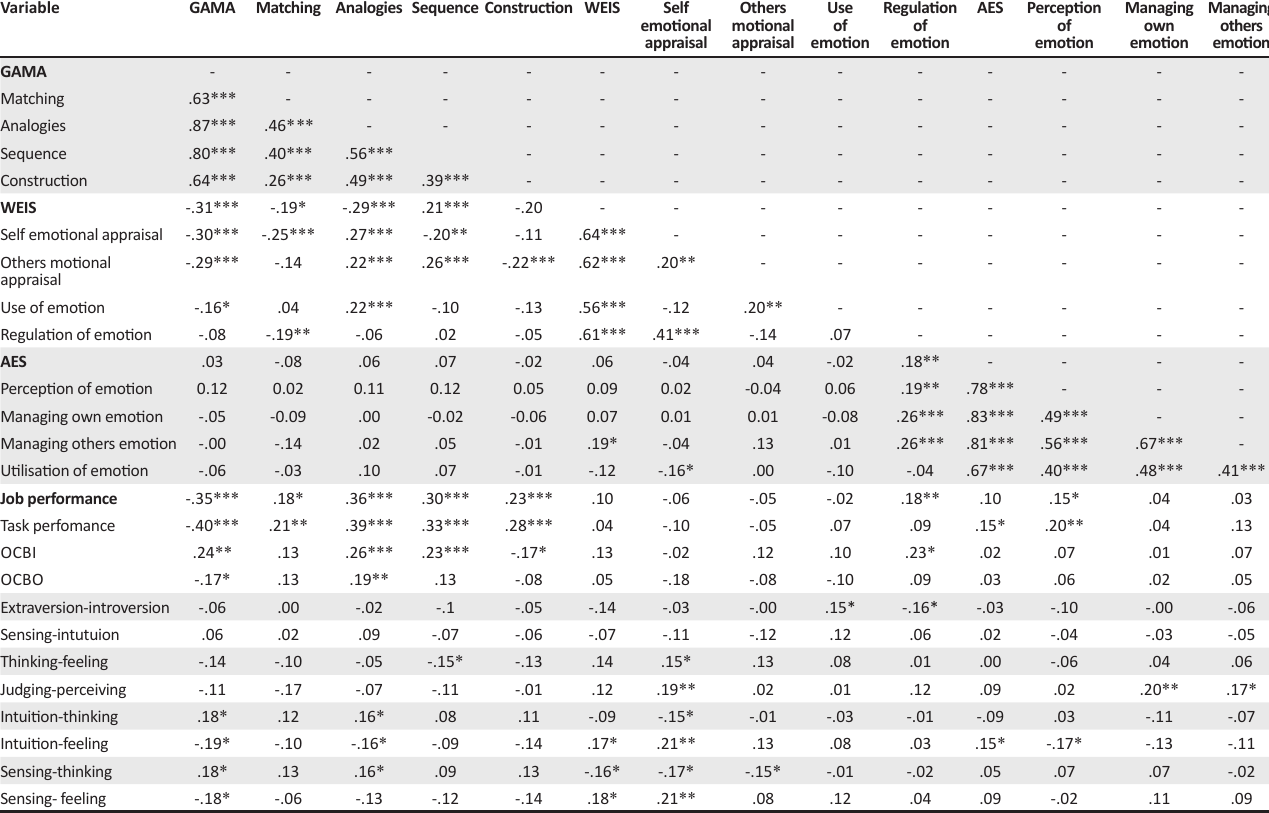
TABLE 4: Bivariate correlations of the dependent and predictor variables.